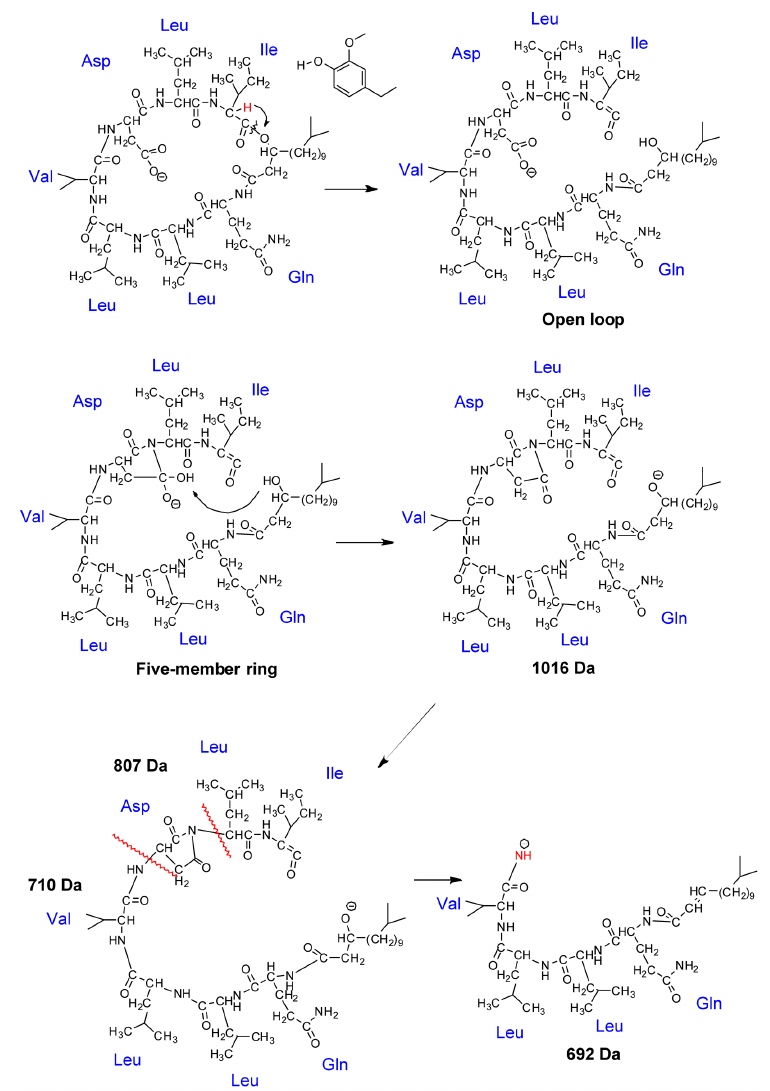
Figure 5. The fragmentation mechanisms of non-covalent complex.